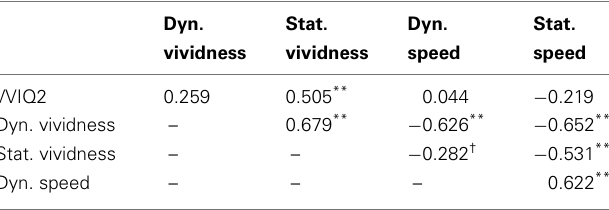
Table 2 | Correlation matrix amongVVIQ2 and self-reported image vividness ratings and perceived generation speed in dynamic and static imagery conditions of Experiment